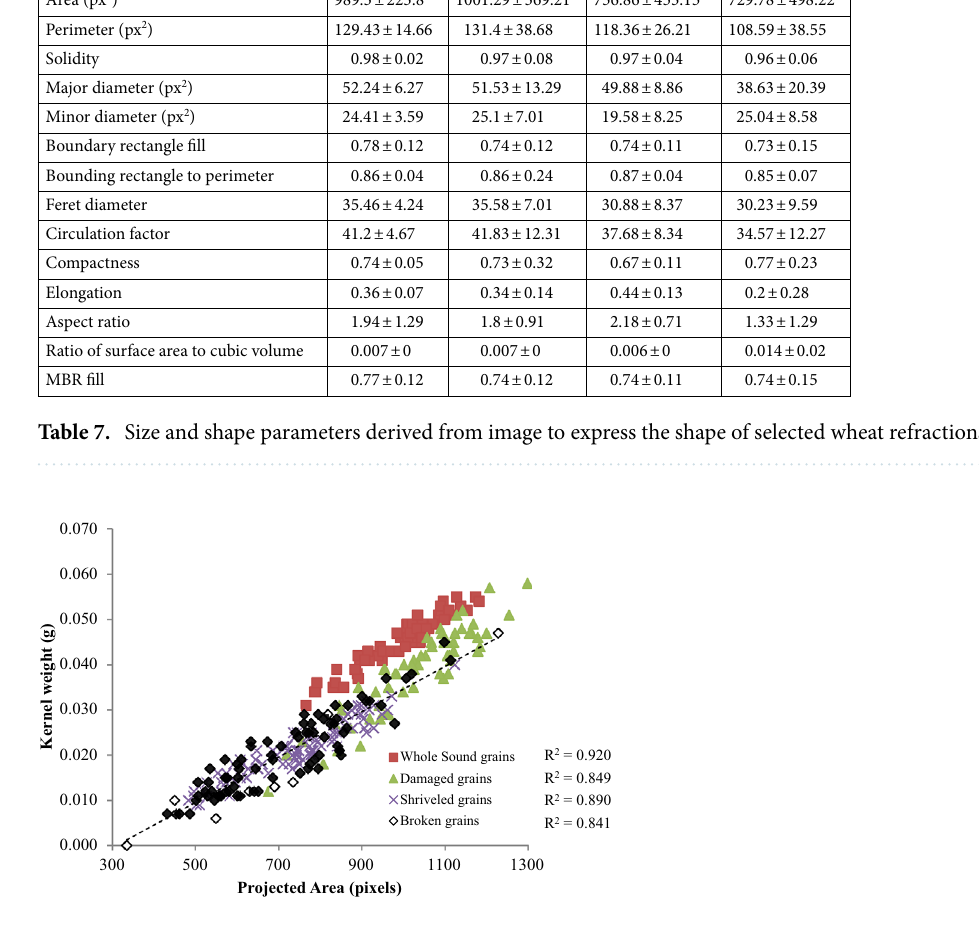
Figure 6. Relationship between the individual kernel weight of refractions measured with weighing balance and the calculated from image.